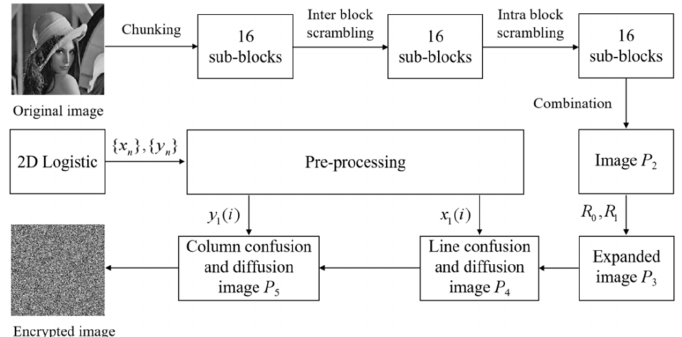
Figure 4. Image encryption framework.